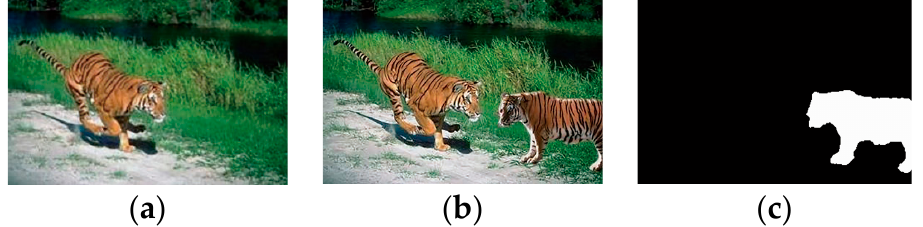
Figure 1. Example of image splicing tampering. ( a ) Original image; ( b ) splicing image; ( c ) ground truth.